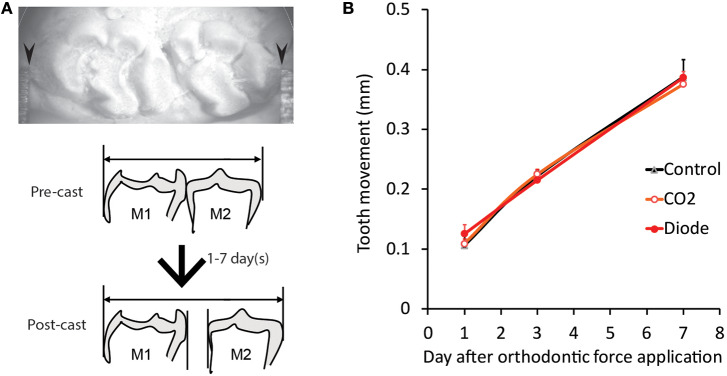
Effects of laser irradiation on orthodontic force-induced ETM. (A) Representative photomicrograph of tooth movement measurement in the plaster model (post-cast) (top) and schematic drawing of the lateral view of the pre- and post-casts of the molars (bottom). (B) The distance of tooth movement at one (D1), three (D3) and seven (D7) days after the application of orthodontic force in each experimental group. Arrowheads: contact point between the molars of the plaster model and the Vernier caliper.